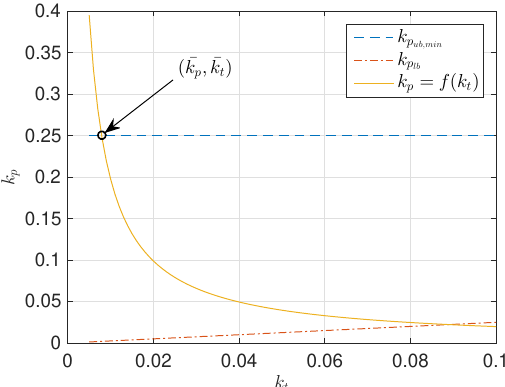
Figure 10. Solid line: feasible values of the scaling coefficients ( k p , k t ) resulting from Equation (48); dashed lines: lower bound ( k p pair ( ¯ k p , ¯ k t )